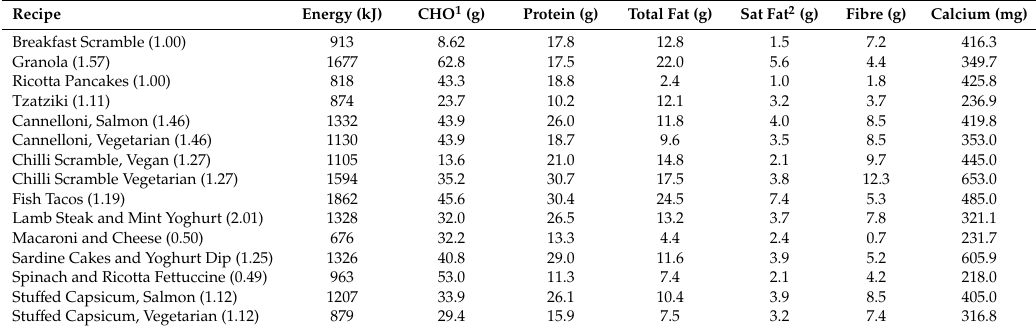
Table 1. The 15 Video Recipes (run time in minutes.seconds) and the Nutritional Analysis Per Serve. Recipe Energy (kJ) Breakfast Scramble (1.00)